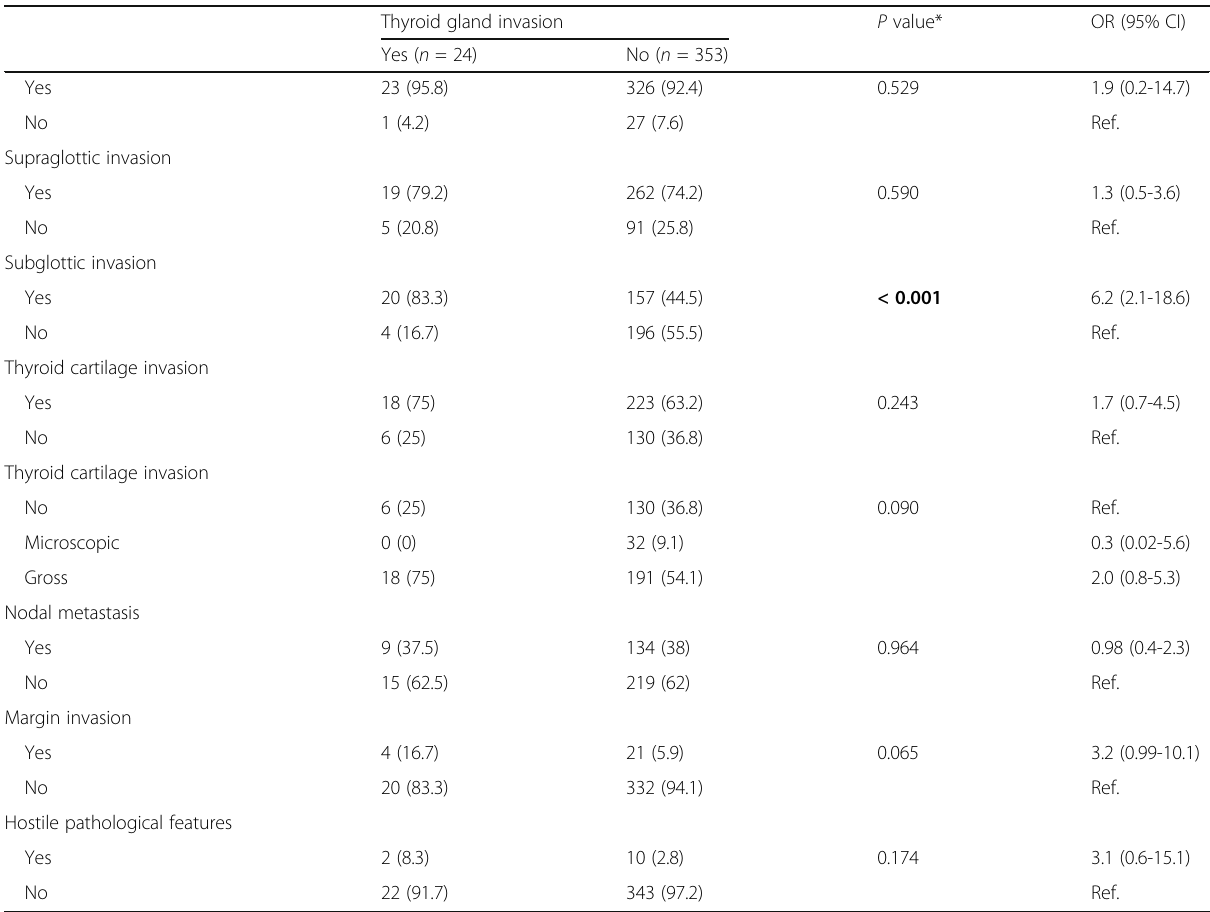
Table 2 Analysis of the correlation of all variables and the incidence of thyroid gland invasion by the LC (Continued) Thyroid gland